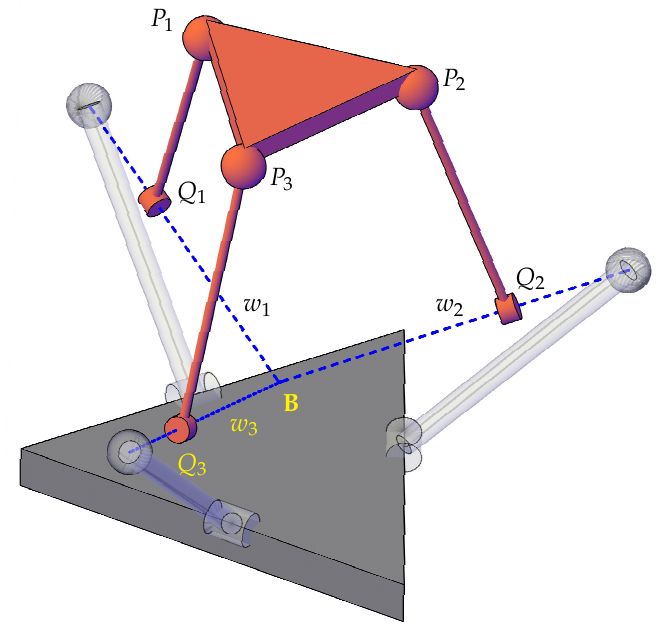
Figure 4. The reduced parallel structure: points Q i , axes w i and points P i